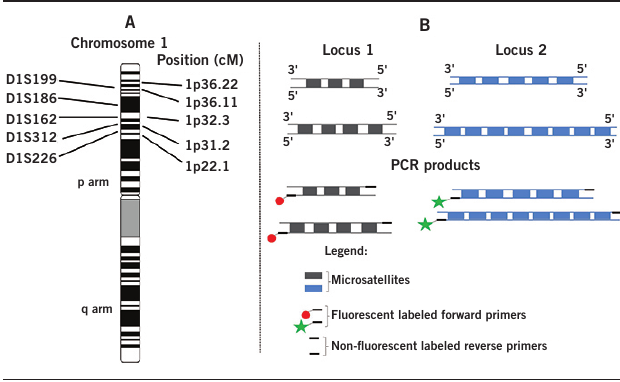
figurE 1 − Amplification of microsatellite regions using the multiplex PCR technique PCR: polymerase chain reaction; LOH: loss of heterozygosity. This molecular procedure consists of a series of repeated cycles for amplification of microsatellite regions of 1p and 19q chromosomes using microsatellite primers. A) In the illustrated example, microsatellite loci located in chromosome 1p were used for the loss of heterozygosity (LOH) assay; B) fluorescent labeled forward and non-fluorescent reverse primers are used in PCR amplification producing amplicons at each PCR cycle, so that after 20-30 cycles, greater than 1 million-fold amplification is reached. At the end of PCR, the majority of generated fragments in the loci 1 and 2 are fluorescent.